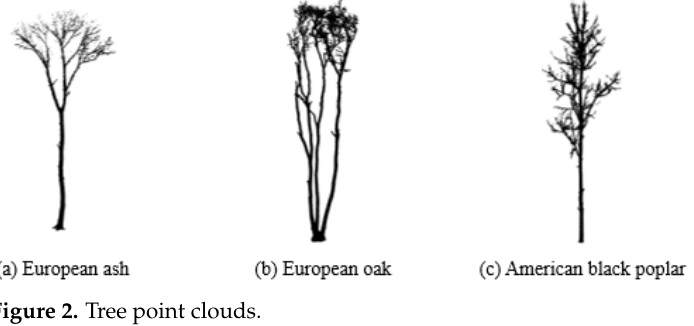
Figure 2. Tree point clouds.